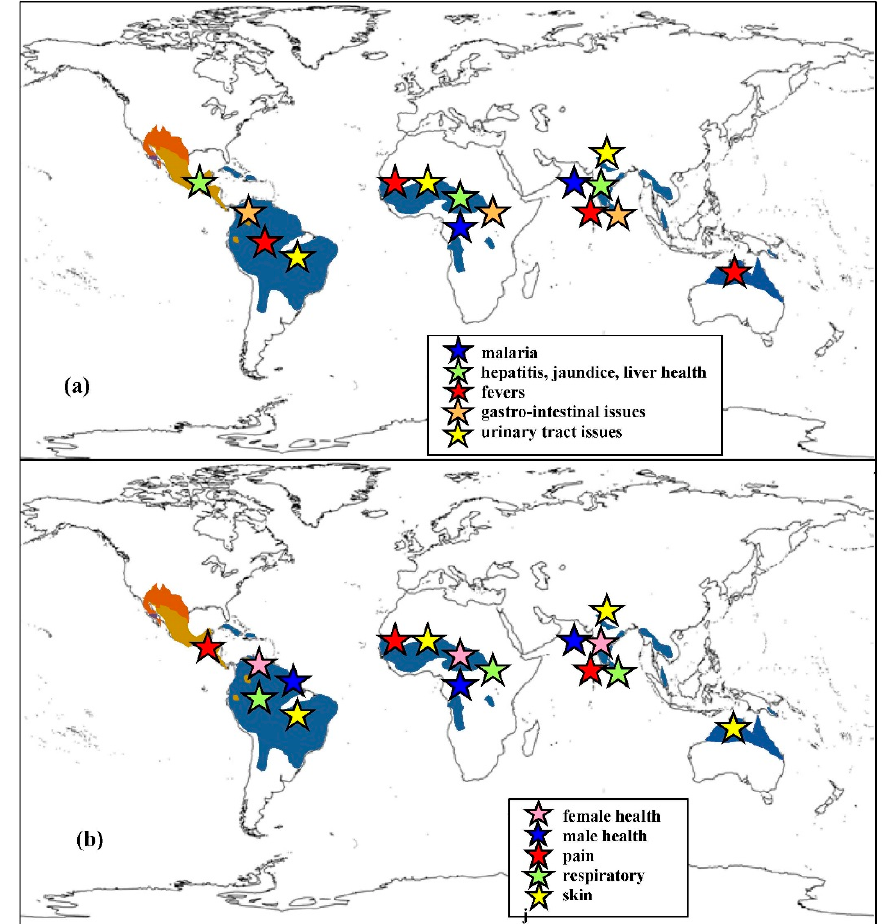
Figure 6. Comparing medicinal use throughout the geographic range of Cochlospermaceae. World maps illustrating general geographic regions where species of Cochlospermacea are being used to treat similar ailments: ( a ) malaria, hepatitis/jaundice/liver ailments, fevers, gastro-intestinal issues, and urinary tract issues; ( b ) female and male health issues, pain, respiratory ailments, and skin issues. Medicinal uses were divided between two maps to avoid overlapping stars.